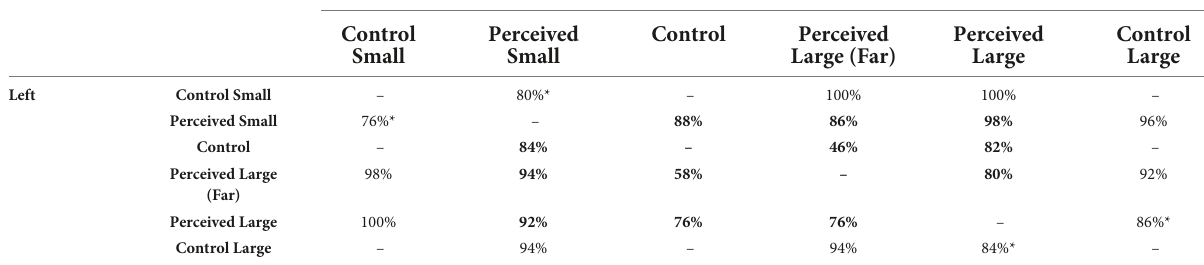
TABLE 7 Experiment 3 perceptual